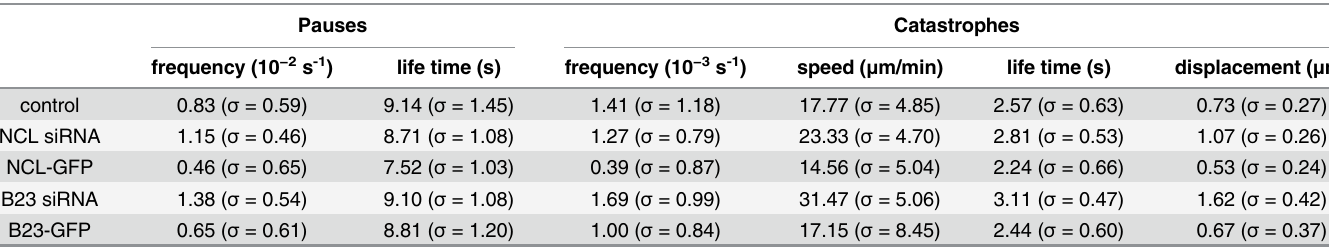
Table 2. Pause and frequency